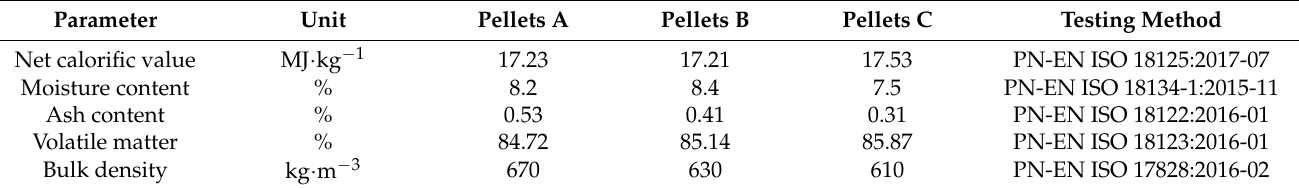
Table 2. Characteristics of the wood pellets tested.